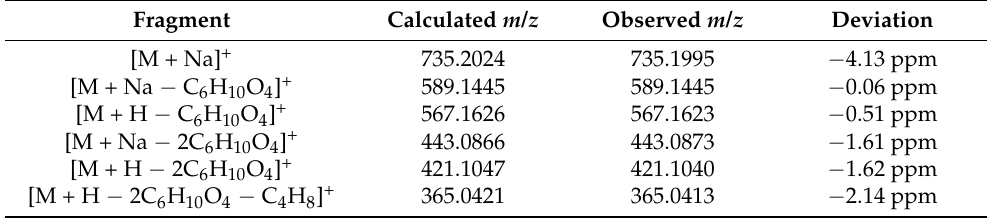
Figure 12. Structure of the synthesized of Isobutyl methylphosphonyl-modified flavonoid (com- pound 7). Table 7. The deviations between calculated and observed m / z values of each fragment derived from compound 7